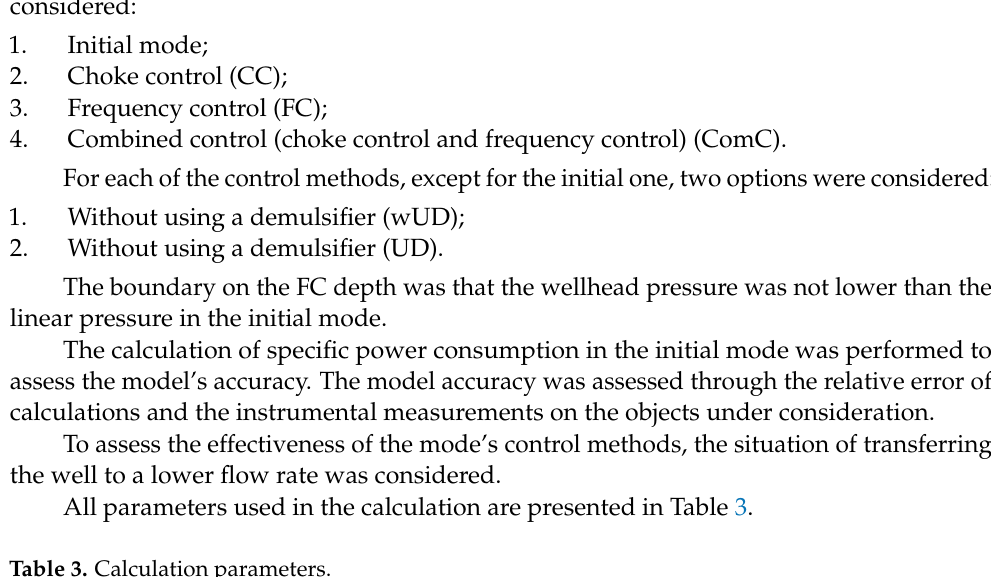
Table 3. Calculation